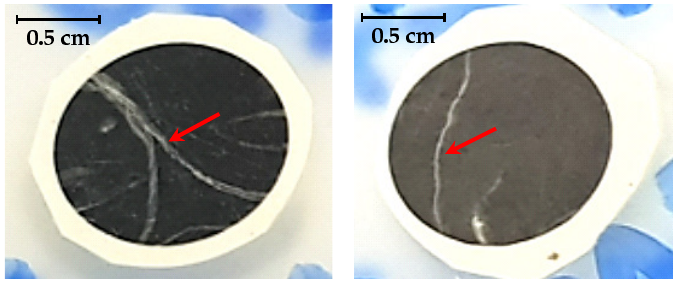
Figure A2. Fractures occurred after extraction on an example of the Darcypress